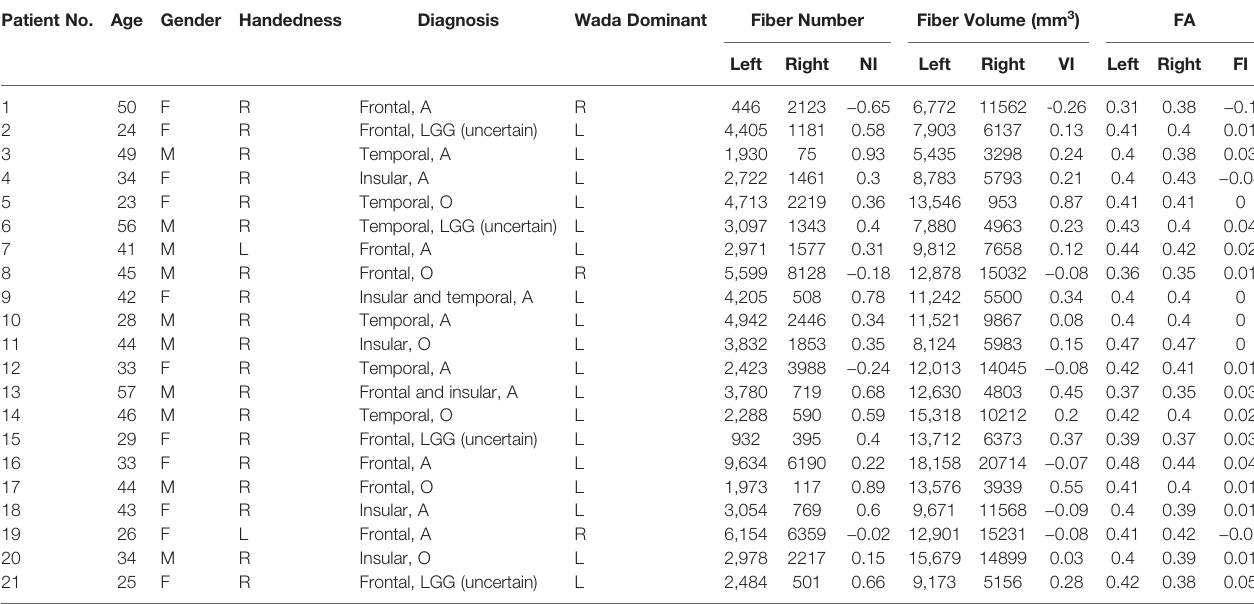
TABLE 2 | General data of patients and DTT metrics of arcuate fasciculus. Patient No. Age Gender